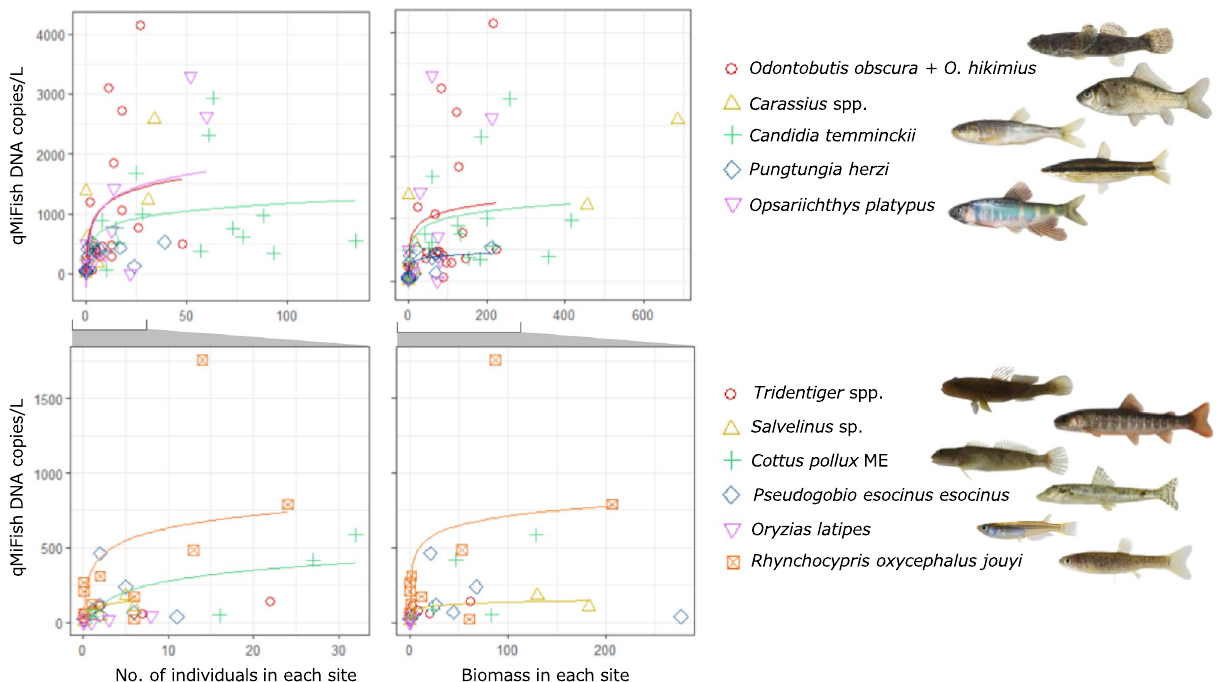
Figure 5. Relationship between the qMiSeq eDNA concentrations quantified and capture data (abundance or biomass) for each taxon at each study site. Each taxon was allocated to either upper or lower panels according to the abundance/biomass level. Coloured solid lines indicate only those results of generalized linear models (GLM) based on negative binomial distribution that were significant. Photo copyright: O. obscura , C. temminckii , P herzi , C. pollux ME, P. esocinus esocinus and R. oxycephalus jouyi for Mr. S. Kunumatsu; Carassius spp. and O. latipes for Mr. Y. Fuke; O. platypus and Salvenius sp. for ffish.asia (https:// ffish. asia/, 2022.04.18 downloaded); Tridentiger spp. for S.T.